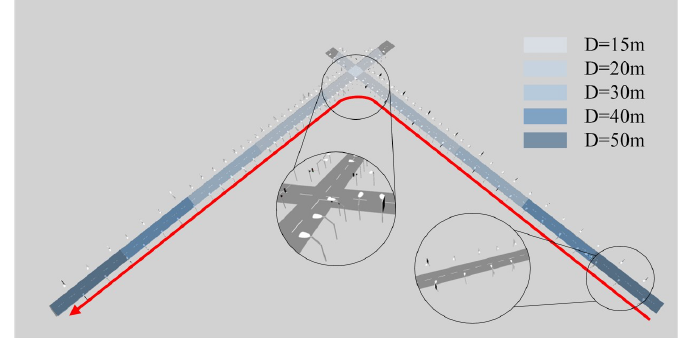
Figure 6. Virtual traffic scenario in simulation setup. The red line denotes the vehicle trajectory.